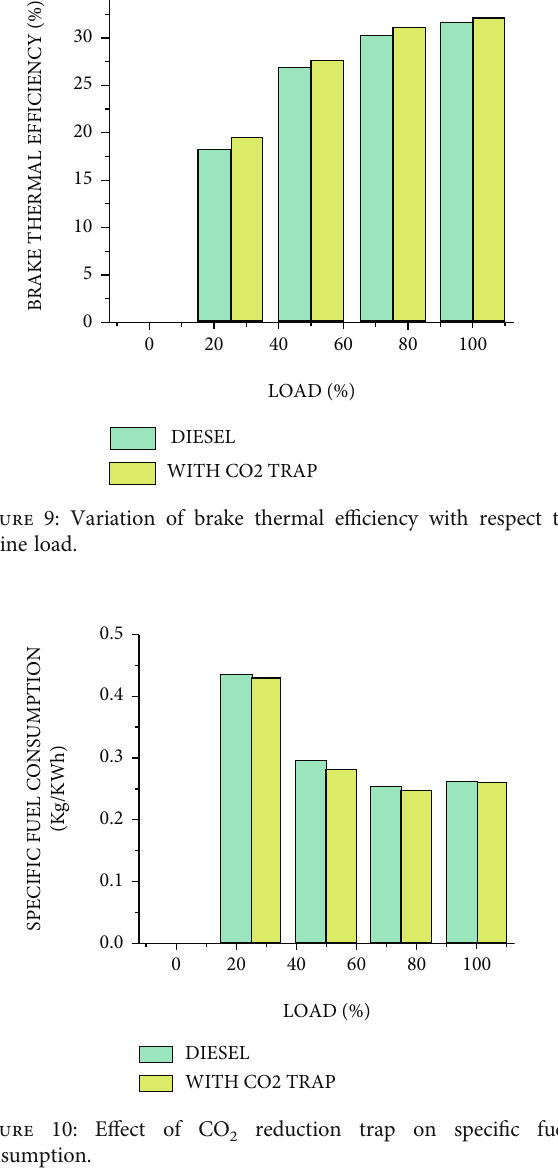
reduction trap on speci fi c fuel 2